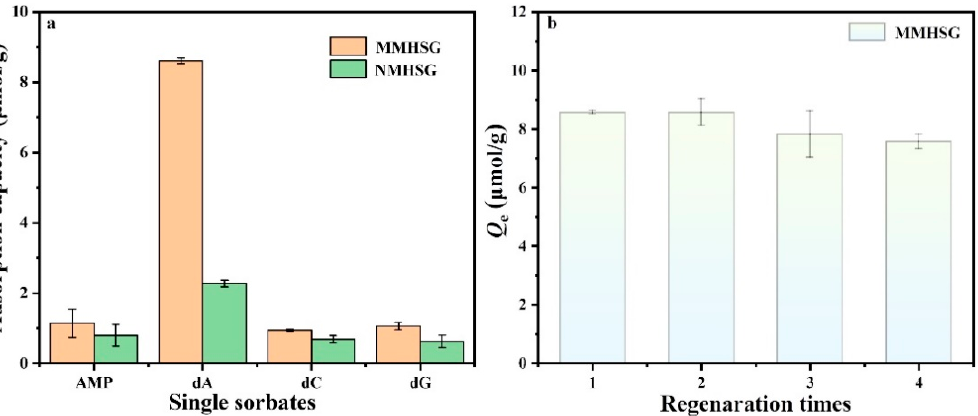
Figure 10. Selectivity adsorption capacity of MMHSG and NMHSG for dA, dG, dC, and AMP ( a ), and regeneration analysis of MMHSG via four sequential adsorption/desorption cycles ( b ). Table 4. Comparison of the imprinting factor of MMHSG toward dA with the other reported MIPs.